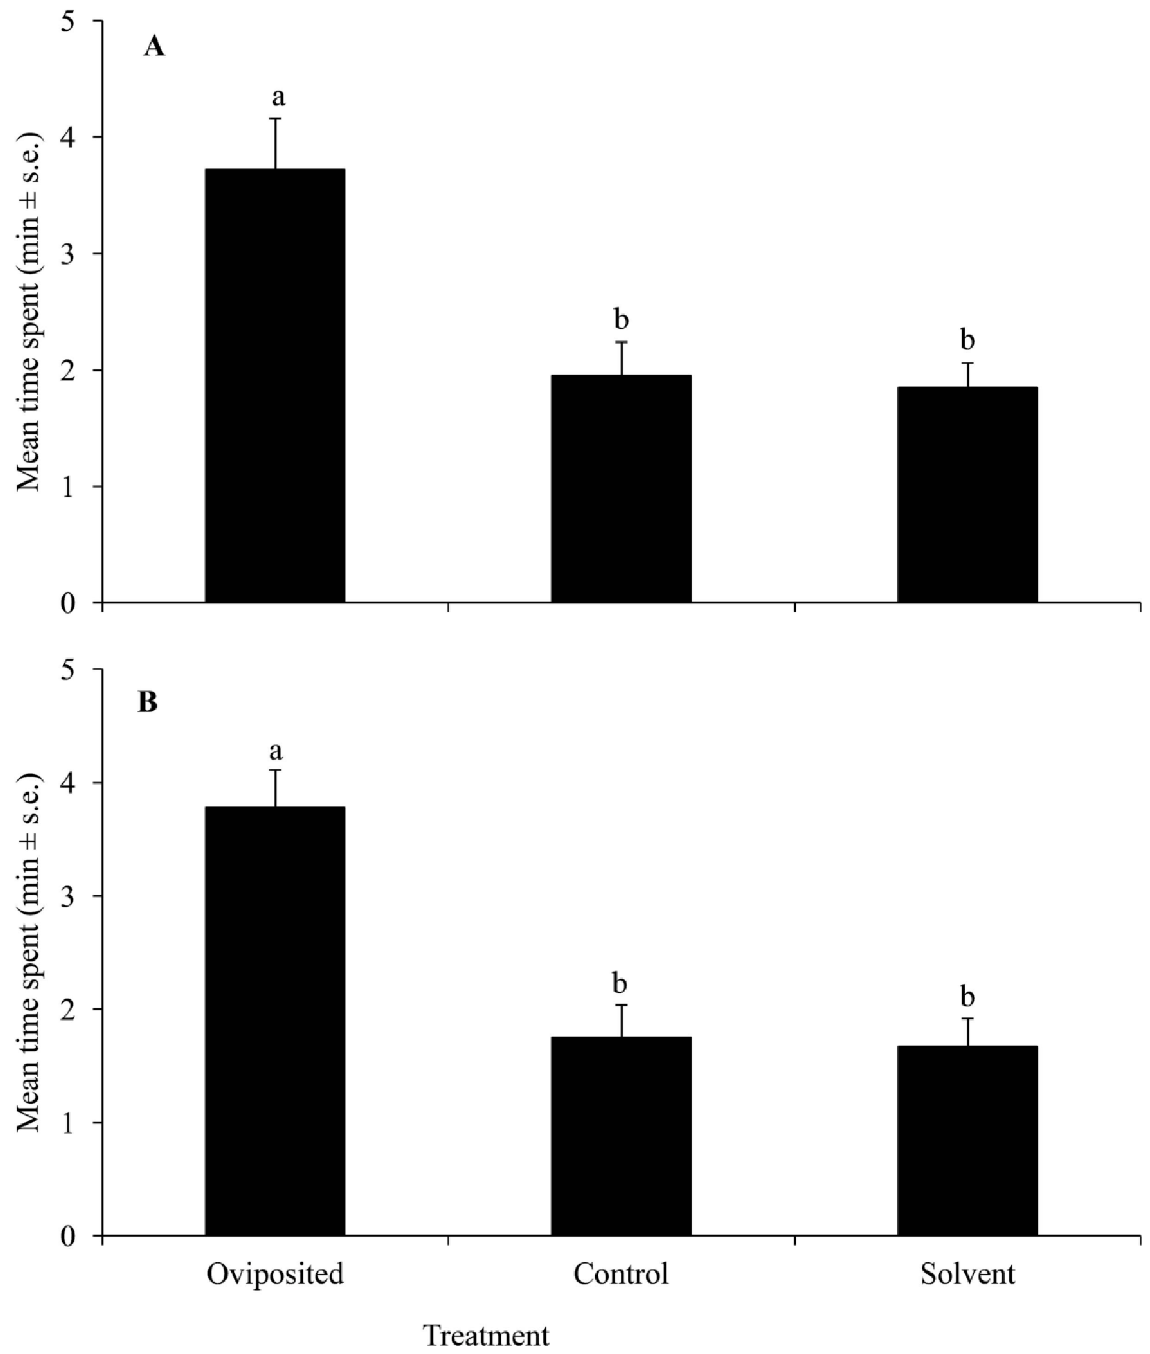
Fig 1. Behavioural response of female parasitoids to volatiles collected from landrace maize seedlings, ‘ Nyamula ’ with or without Chilo partellus eggs in a four-arm olfactometer bioassay. Response of ( A ) Trichogramma bournieri ; ( B ) Cotesia sesamiae . Bars marked by different letters within a graph are statistically different ( P <